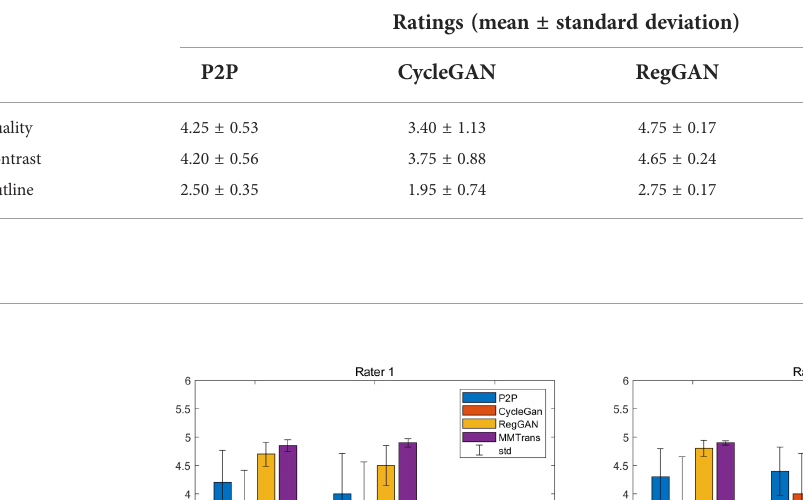
TABLE 2 Compare the mean scores of translated images given by P2P images, CycleGAN images, RegGAN images, and MMTrans images.